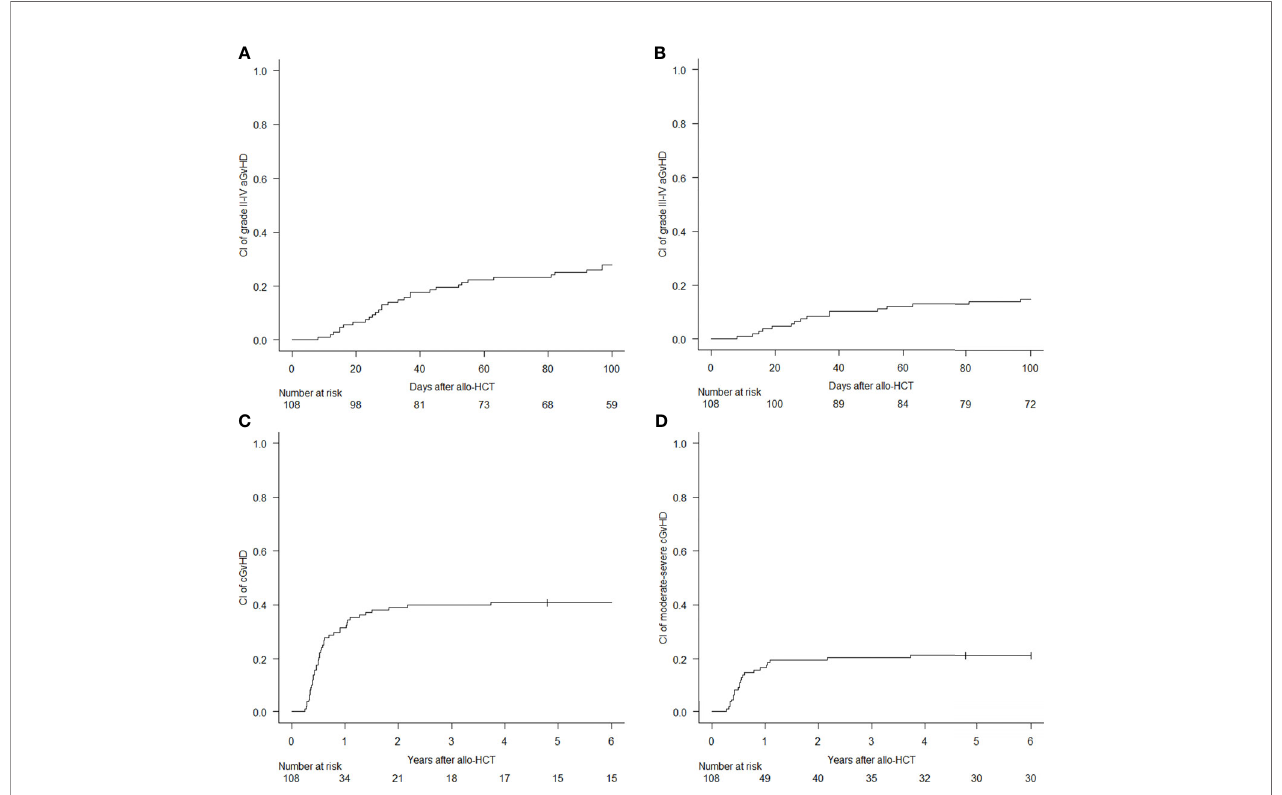
FIGURE 2 | Cumulative incidence (CI) of acute graft- versus -host disease (GvHD) grade II – IV (A) and III-IV (B) , and CI of chronic GvHD all grades (C) and moderate- to-severe (D)